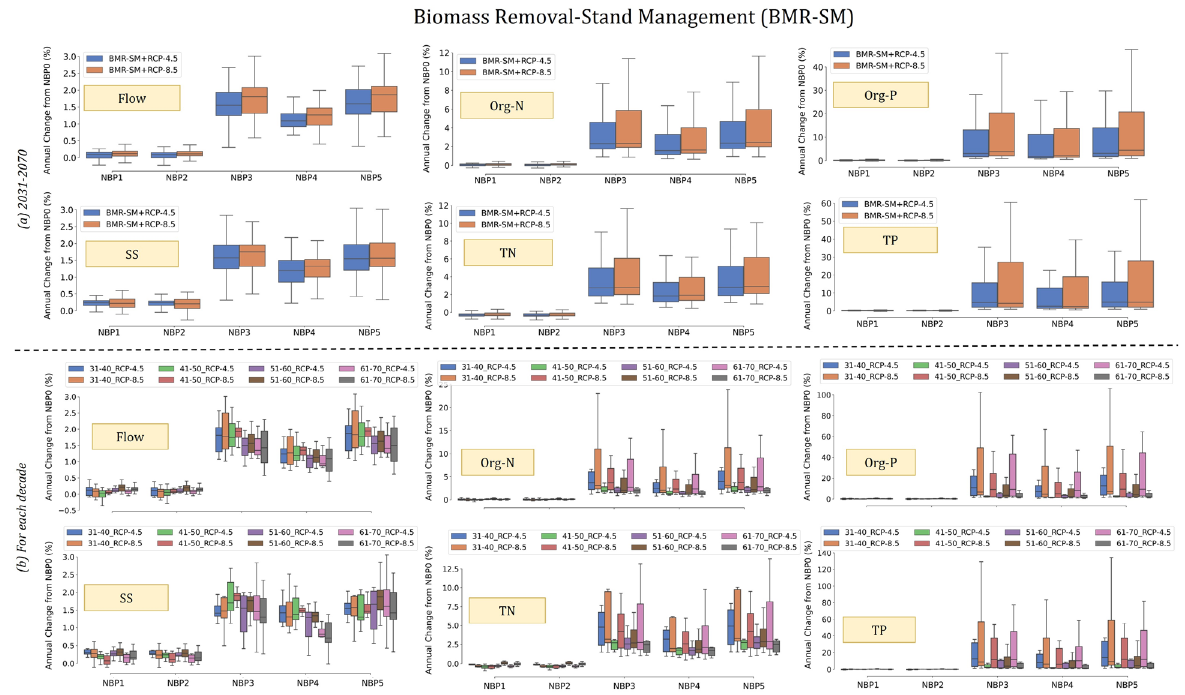
Figure 4. Variations in annual flow, nutrients, and SS for the BMR-SM attribute of each NBP compared to NBP 0. The top panel represents the variations of the modelled response variables from 2031 to 2070 whereas the bottom panel is showing the results of each